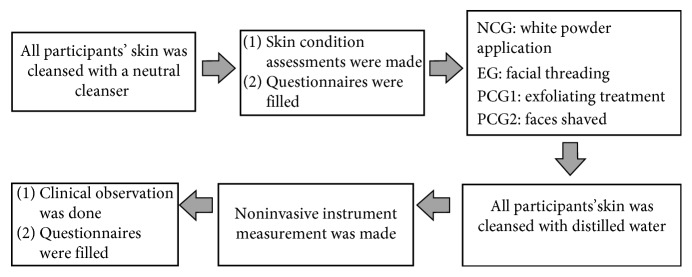
Experiment design.